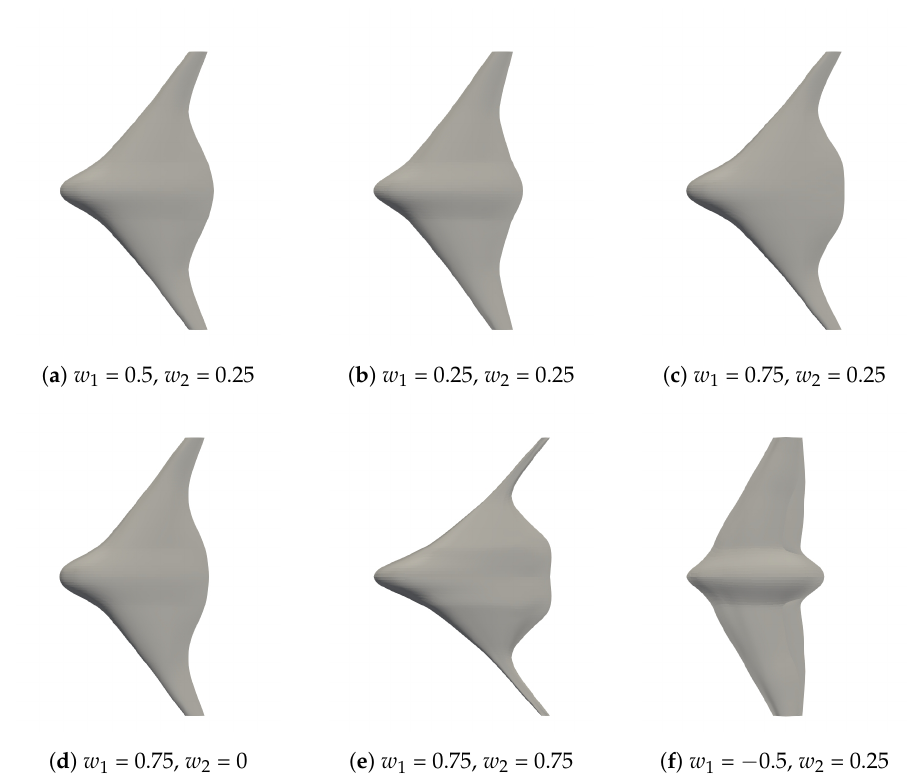
Figure 7. Several BWB aircraft created with the flattening-based morphing method. The weights of each morphed BWB aircraft are presented in the caption. The weights of the aircraft plotted in ( a – d ) exist in the current study’s design space, but the ones plotted in ( e , f ) are located outside of the design